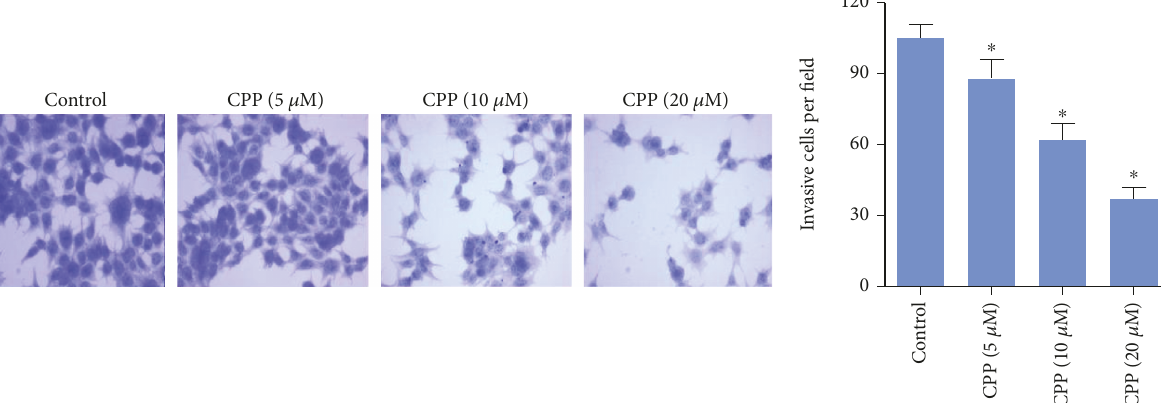
Figure 3: Invasion of HepG2 cells. ∗ P < 0 05 versus Control